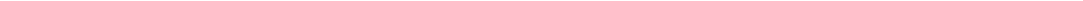
Fig. 7 AR regulates differential metastasis in vivo via miR-185-5p. a – d The animals were killed 12 weeks later for primary RCC and metastases detection by ex vivo bioluminecent imaging ( upper two panels), gross examination ( middle panels), and histological staining with haematoxylin and eosin ( H & E ) ( lower two panels). Scale bars in 10×, 20×, and 40× represent 200 μ m, 100 μ m, and 50 μ m, respectively. a Primary RCC from control group. Tumor sizes were about 2 cm. b , c Representative photographs showed pulmonary and hepatic metastases from OE-AR group, macroscopically visible in lung or liver surface metastatic nodules ( arrows or circles indicated) and microscopically visible nodules by H&E staining. d Representative photographs of lymph node metastases. Retroperitoneal lymph nodes after resection of all the abdominal organs ( second panel), and pulmonary or renal hilum lymph nodes were gross examined by anatomical analysis ( third panel) and con fi rmed by H&E staining ( lower two panels). e Array diagram showed the hematogenous metastatic status of each mouse in various groups. Whether tumor metastasized or not referred to in/ex vivo bioluminescent or macroscopic imaging and con fi rmed by H&E staining. Number in each cell represents the visible surface metastatic nodules in left/right lung and liver. Green = no metastasis, red = > 15 nodules in two layers (with a distance of 3 mm) calculated into total numbers. f Quantitation ( χ 2 -test) of hematogenous metastases. Each group compared to control group. g Array diagram showed the lymphatic metastases of every mouse in various groups (0 = negative, 1 = positive). h Quantitation ( χ 2 -test)